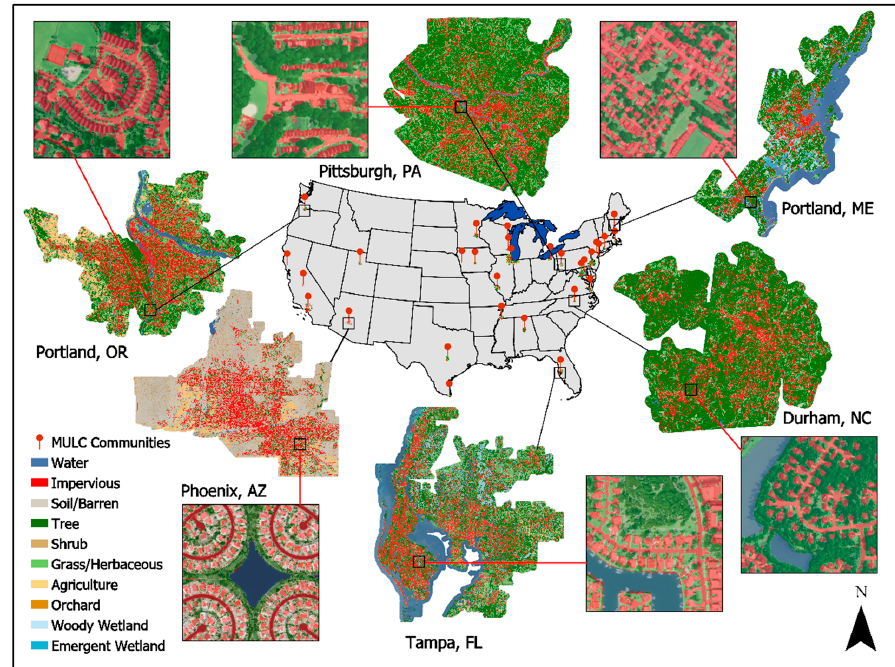
Figure 1. Comparison of spatial scale and level of detail of ( a ) Meter-Scale Urban Land Cover (MULC) (1 m pixel) and ( b ) National Land Cover Dataset (NLCD) (30 m pixel) in a Pittsburgh, PA neighborhood and golf course. Land cover 50% transparency over NAIP imagery.